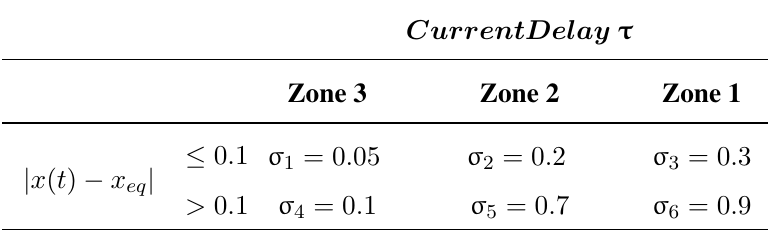
Table 1. Proposal of σ values for the adaptive self-triggered strategy.